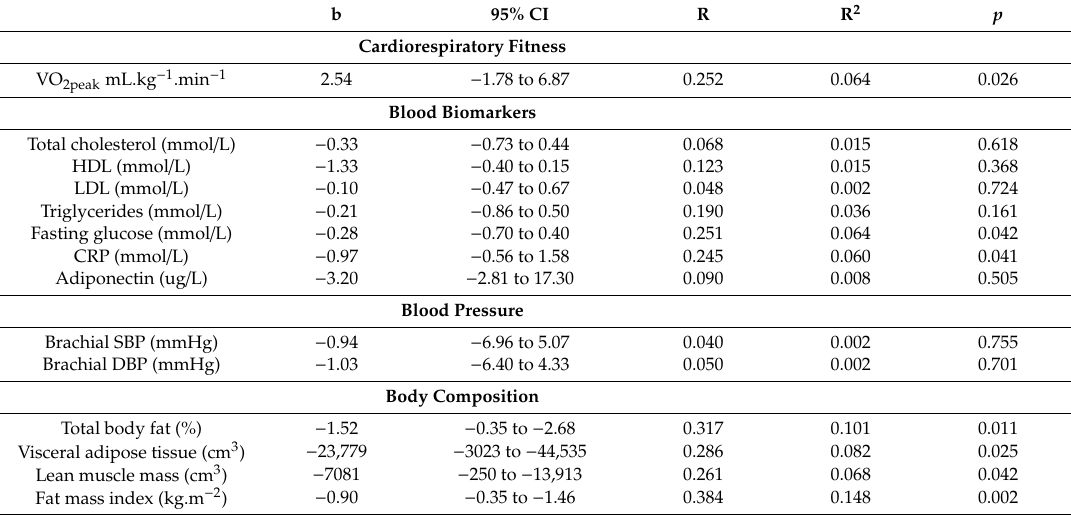
Table 3. Multiple linear regression analysis between ketosis and changes in cardiorespiratory fitness, body composition and other cardiometabolic